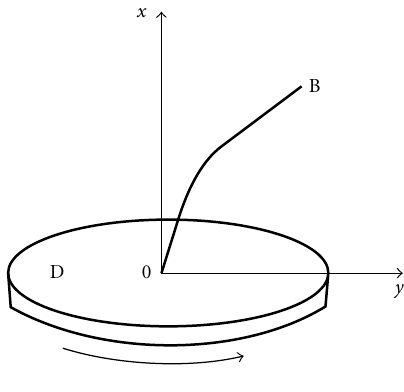
Figure 1.1. The body-beam